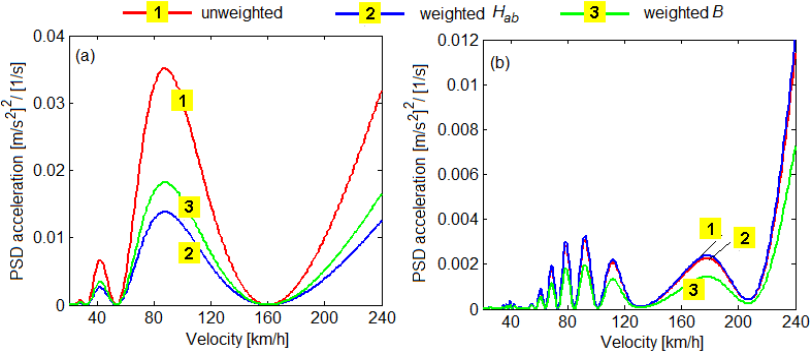
Figure 9. Effect of the frequency weighting upon the carbody dynamic response in the reference point C : ( a ) at the bounce resonance frequency (1.17 Hz);( b ) at the bending resonance frequency (8 Hz).